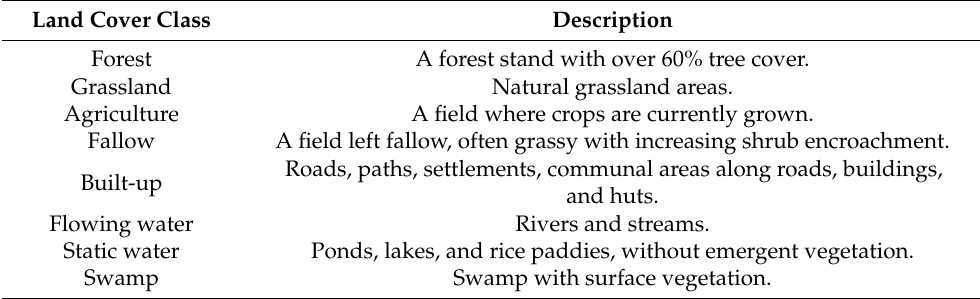
Table 2. Land cover classes, adapted from